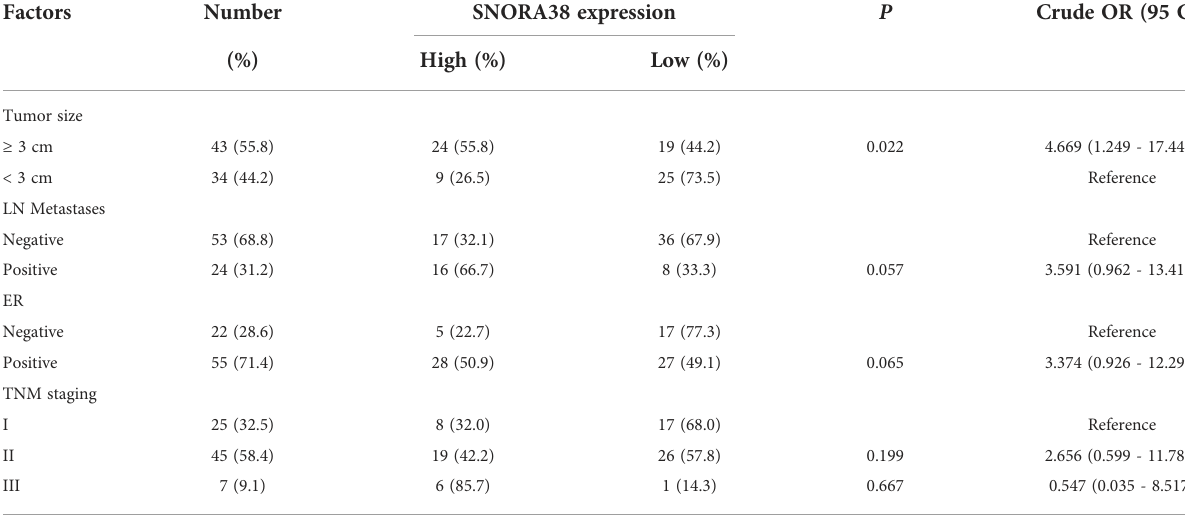
TABLE 2 Multivariate analysis of SNORA38 expression and clinical pathology factor.